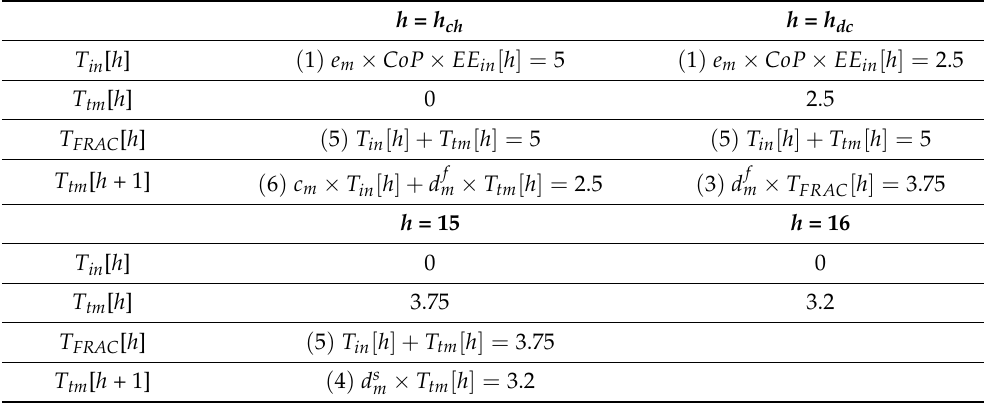
Figure A1. Illustration of example ( a ) gives the energy values ( EE solar , EE in , and EE peak ) and ( b ) gives the temperature values ( T in , T tm , and T peak ). Table A1. Calculation of T in [h ], T tm [h] , T FRAC [h] , and T tm [h+1] for the example; the equation used to make each calculation is included.